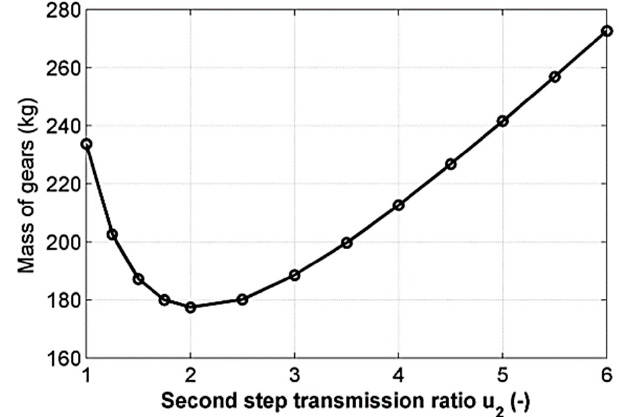
Figure 1. Gear mass versus second stage gear ratio [1].